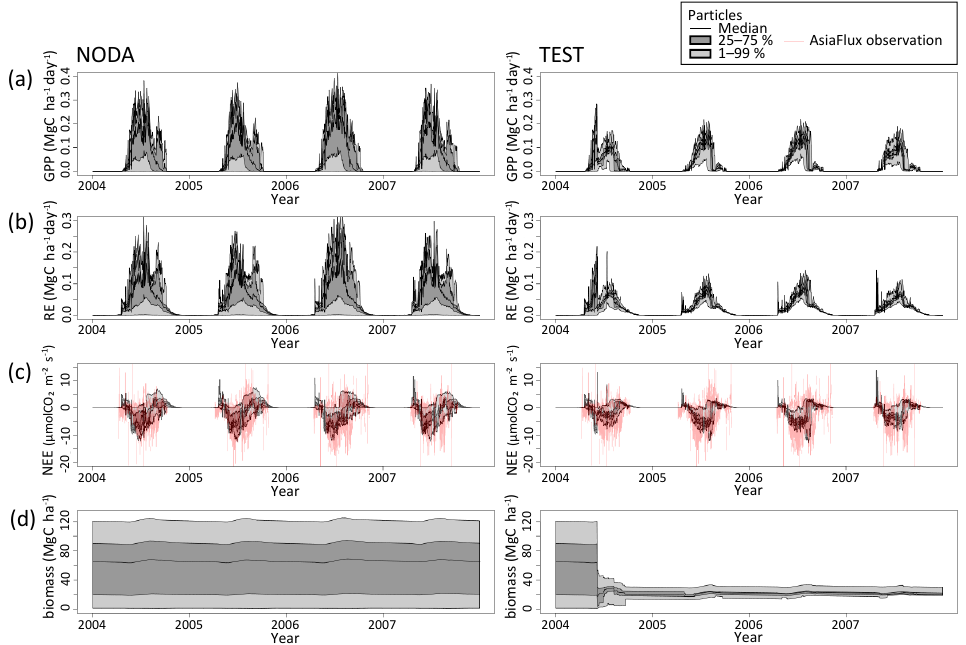
Figure 9. Similar to Fig. 5, showing the unobserved model variables: (a) GPP, (b) RE, (c) NEE, and (d) biomass but for the real-world experiment. Red lines indicate the direct field observations made instantaneously every 30min at the AsiaFlux site, while the model simulates only the daily